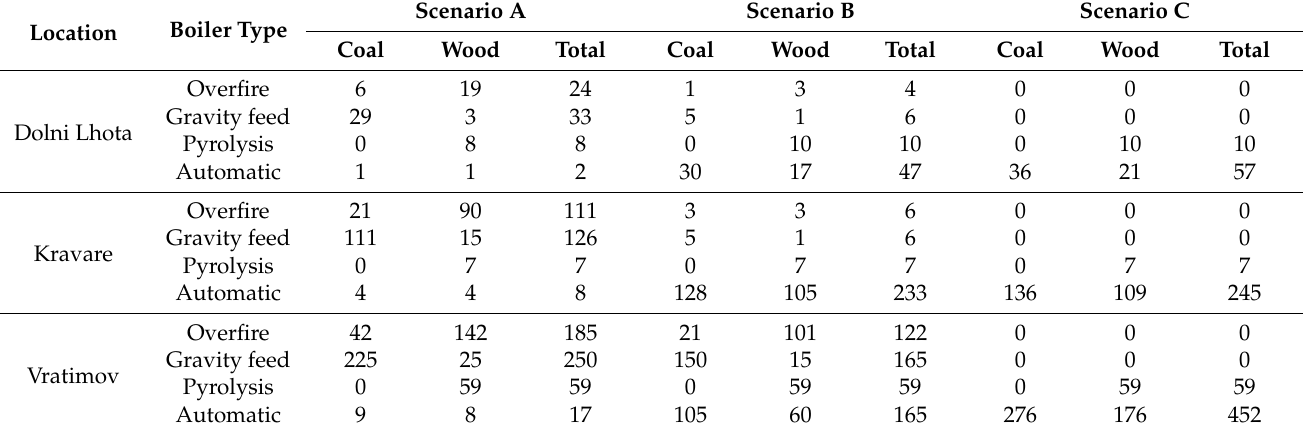
Table 1. Number of solid fuel boilers according to location, boiler type and model scenario.